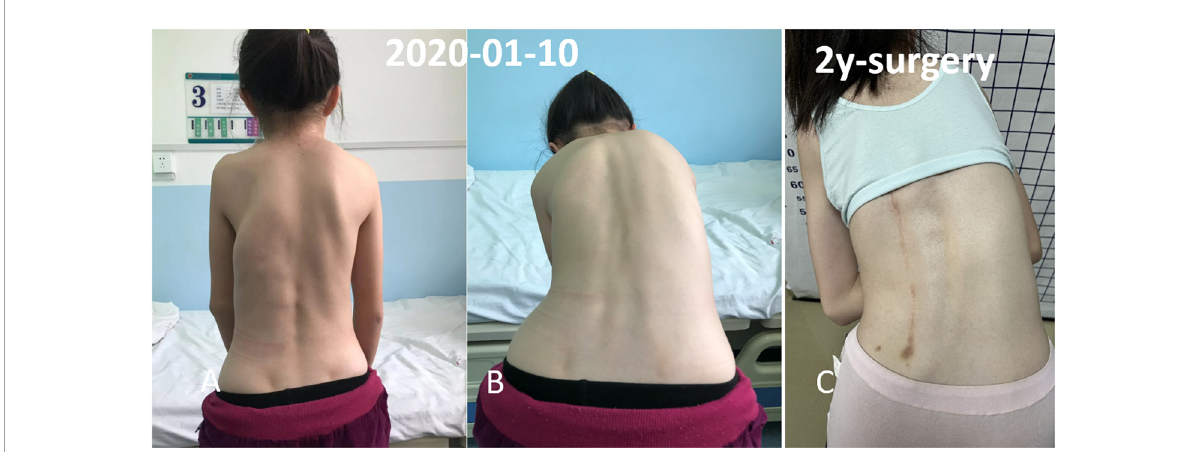
FIGURE3 Multiple irregular, non-tender, bony hard swellings were found on the back and spinal scoliosis. The osseous lesion beginning from the left chest wall, extending to the ilium region. (A,B) Preoperative physical examination. (C) Two year follow-up.